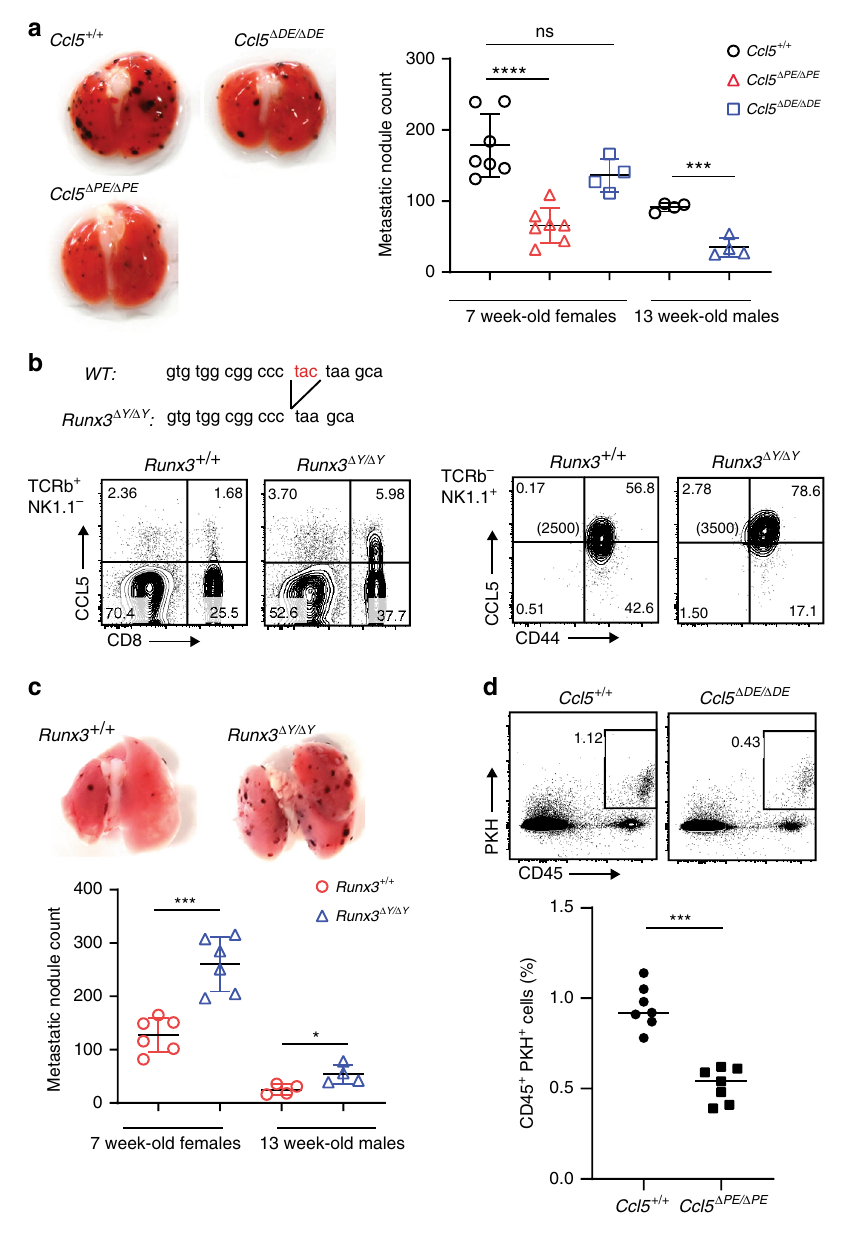
Fig. 7 Homeostatic expression of host CCL5 is important for B16-F10 metastasis. a B16-F10 melanoma cells were intravenously injected into Ccl5 + / + , Ccl5 Δ PE/ Δ PE , and Ccl5 Δ DE/ Δ DE mice. Representative macroscopic images of lungs 14 days after injection are shown. The summary graph on the right shows the numbers of metastatic nodules. Error bars indicate Mean± SD and each dot represents a mouse examined over at least two independent experiments. Statistical signi fi cance is measured via unpaired two-tailed Student ’ s t tests and is presented as follows: *** p < 0.001, **** p < 0.0001, ns nonsigni fi cant. b Sequences of the Runx3 Δ Y allele con fi rmed the removal of the last tyrosine residue from the RUNX3 protein in Runx3 Δ Y/ Δ Y mice. The TAC codon for tyrosine was changed to a TAA stop codon (upper). Contour plots showing CCL5 expression in T and NK cells of Runx3 + / + and Runx3 Δ Y/ Δ Y mice (bottom). One representative plot of four independent mice are shown. Numbers in the plots indicate the percentage of cells in each quadrant, and numbers in parentheses indicate the mean fl uorescent intensity of CCL5. c The result of B16-F10 melanoma lung metastasis in Runx3 + / + and Runx3 Δ Y/ Δ Y mice is shown as in a . Error bars indicate Mean± SD and each dot represents a mouse examined over at least two independent experiments. Statistical signi fi cance is measured via unpaired two-tailed Student ’ s t tests and is presented as follows: * p < 0.05, *** p < 0.001. d The result of YAC-1 cancer model. PKH67- labeled mouse lymphoma YAC-1 was injected i.v. into Ccl5 + / + and Ccl5 Δ PE/ Δ PE mice and survived cancer cells in lungs were counted. Error bars indicate Mean± SD and each dot represents a mouse examined over at least two independent experiments. Statistical signi fi cance is measured via unpaired two- tailed Student ’ s t tests and is presented as follows: ∗∗∗ p < 0.001. Source data are provided as a Source Data fi